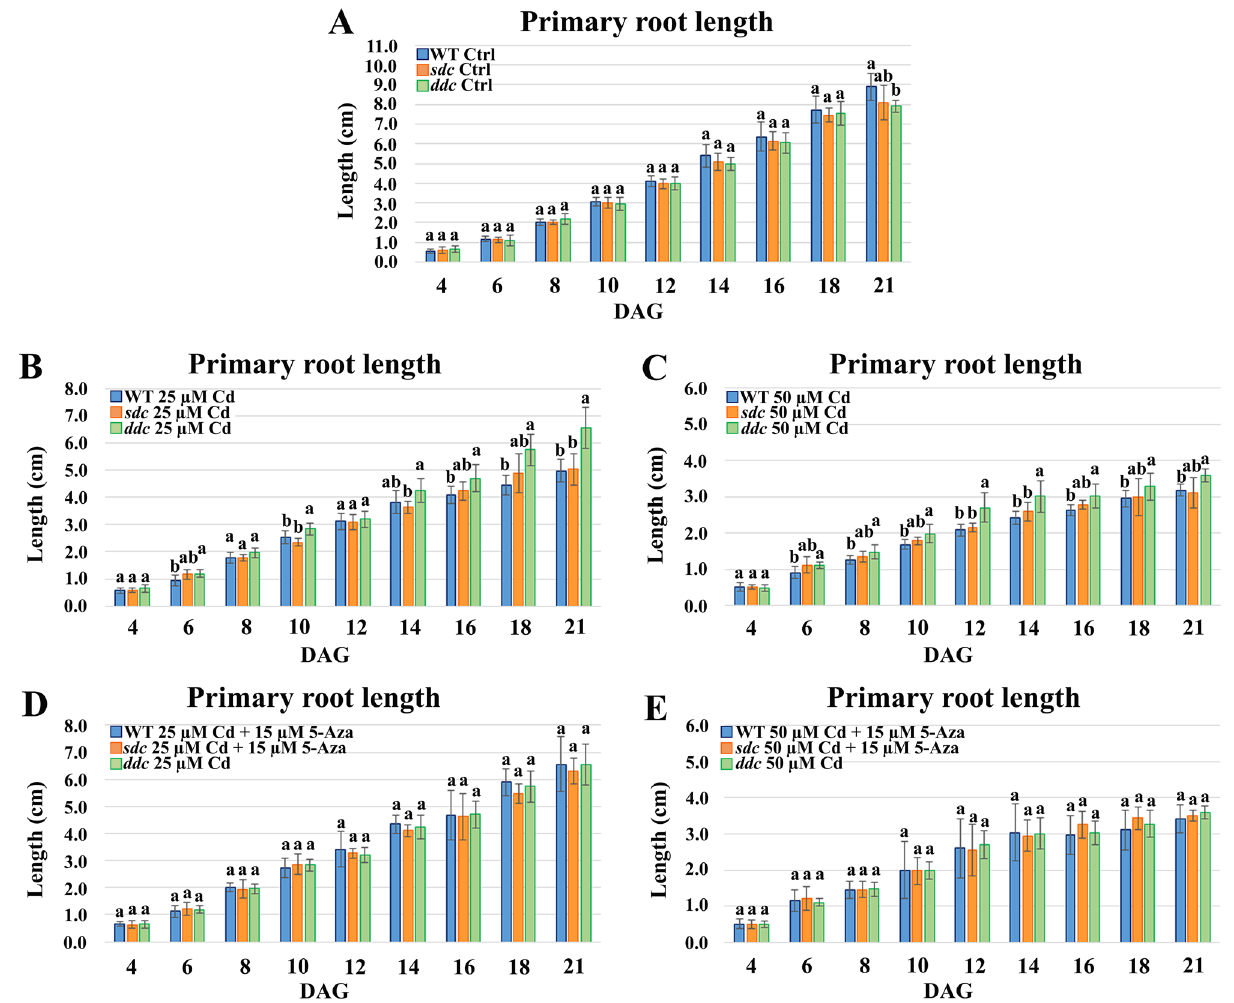
Figure 8. Primary root length of WT, sdc and ddc plants of A. thaliana , germinated and grown in long day condition ( A ) on growth medium without Cd as control (Ctrl), ( B , C ) on a medium supplemented with 25/50 µM Cd, ( D , E ) limited to WT and sdc plants, on a medium supplemented with 25/50 µM Cd plus 15 µM 5-Azacytidine (5-Aza). Root length was monitored up to 21 days after germination (DAG) every two days from germination. The results represent the mean value (± SD) of three independent biological replicates (n = 45). Statistical analysis was performed between samples at the same growth stage, by using two-way ANOVA with Tukey post hoc test ( P ≤ 0.05) after Shapiro–Wilk normality test. Means with the same letter are not significantly different at P ≤